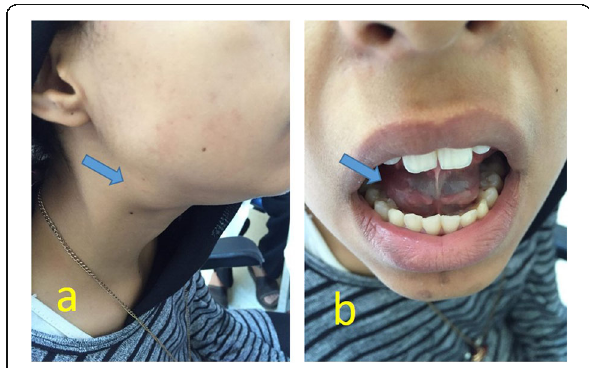
Fig. 1 A patient with two cystic lymphangiomas: right submaxillary ( a ) and in the right side of the floor of the mouth